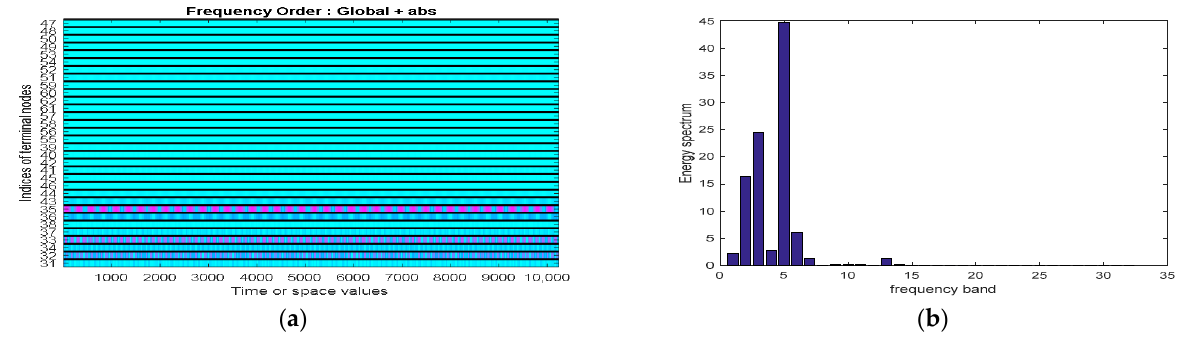
Figure 7. ( a ) bior3.3 wavelet tree termination node; ( b ) energy spectrum of bior3.3 wavelet decomposition.